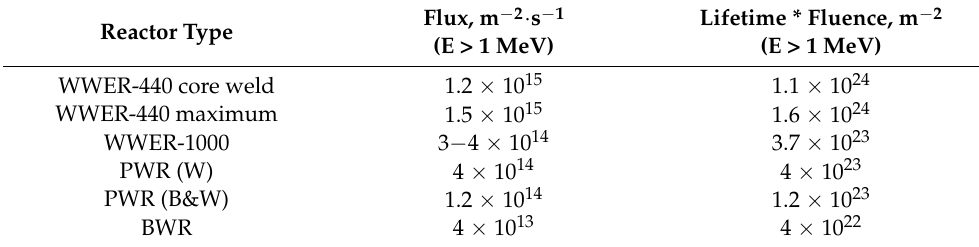
Table 3. Neutron fluence rate and neutron fluence in common reactor (E > 1 MeV)